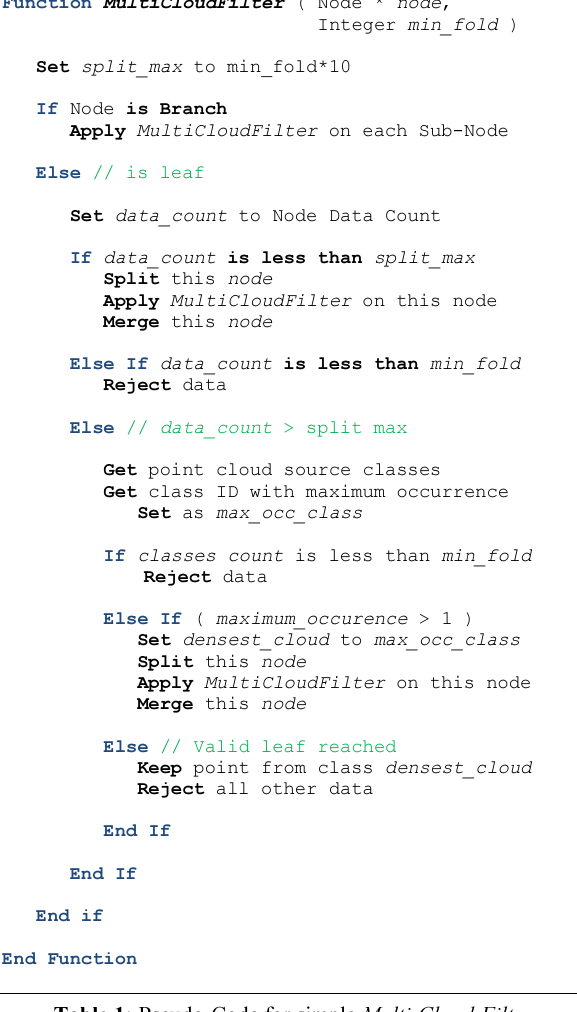
Table 1: Pseudo-Code for simple